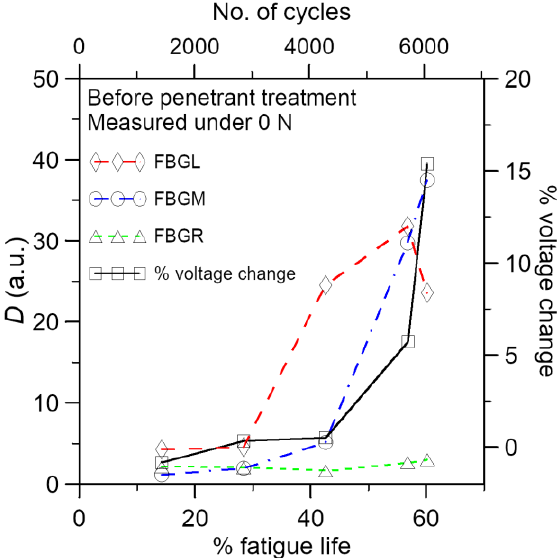
Figure 14. Load-free D values from 3 FBGs and the percentage voltage change development before the application of fluorescent penetrant in a fatigue specimen.